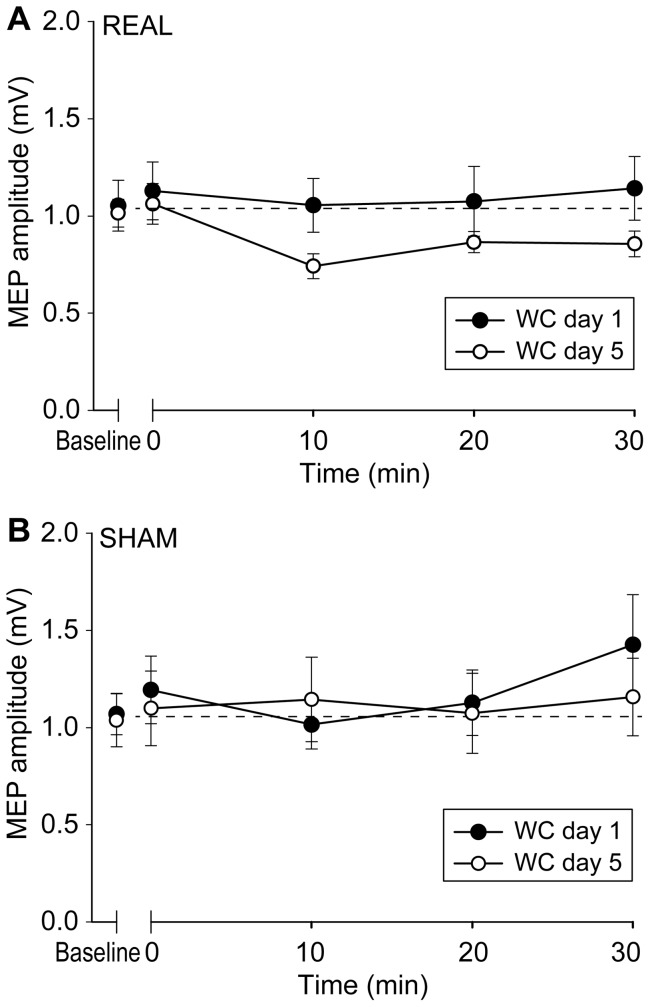
PMd-M1 connectivity in dystonia.In the group that had real stimulation (A), premotor cTBS600 did not change M1 excitability on day 1, while the usual suppression of excitability was restored on day 5. In the group that had sham stimulation (B), no effect was found on MEPs on either day 1 or day 5. Error bars refer to the standard error of the measurements (SEM).